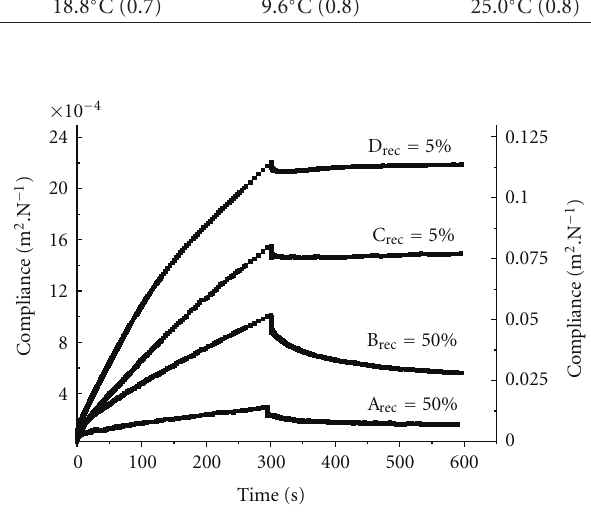
Figure 1: Creep-recovery profiles (37 ◦ C) with indications of recov- ery percentages for the four characteristic rheological behaviour groups, namely, A (left axis): Pluronic F127 at 28% and 23% (without additive; drug; drug + RM β CD); B (left axis): Pluronic F127 at 18% (without additive; drug; drug + RM β CD); C (left axis): F127 at 23% (drug + ethanol); and D (right axis): Pluronic P123 at 28% (without additive; drug; drug + ethanol; drug + RM β